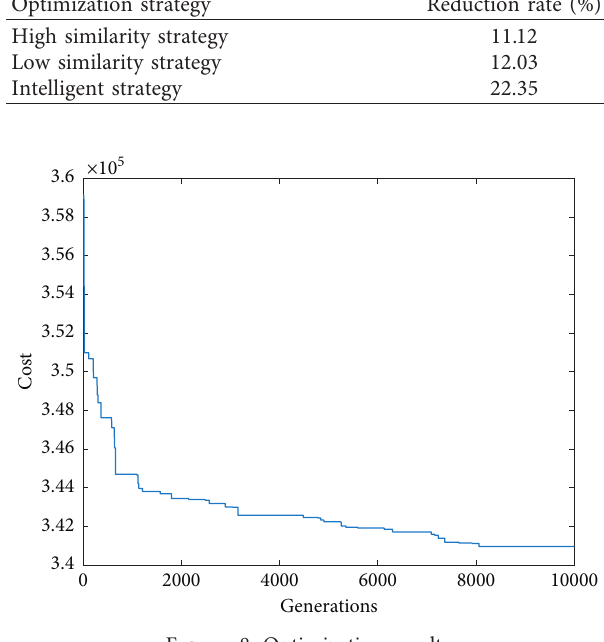
Figure 8: Optimization